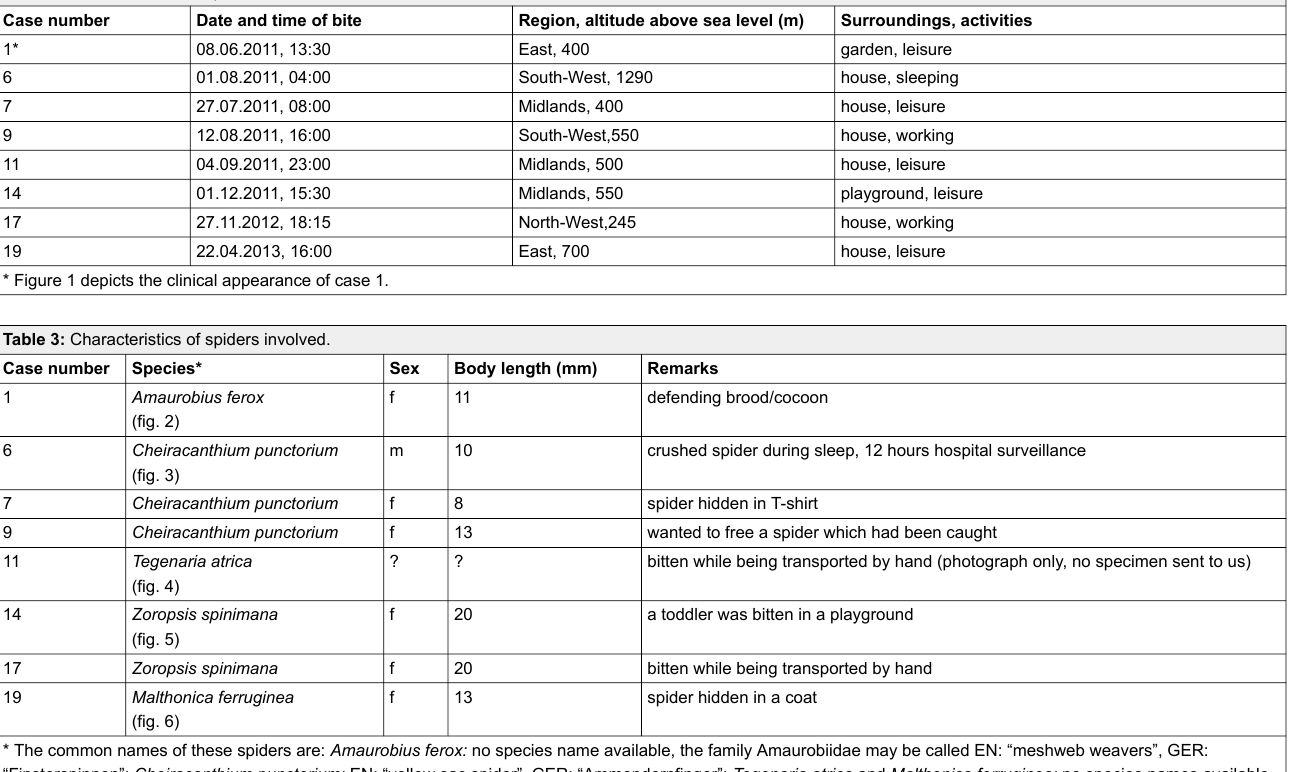
Table 2: Characteristics of spider bite events.